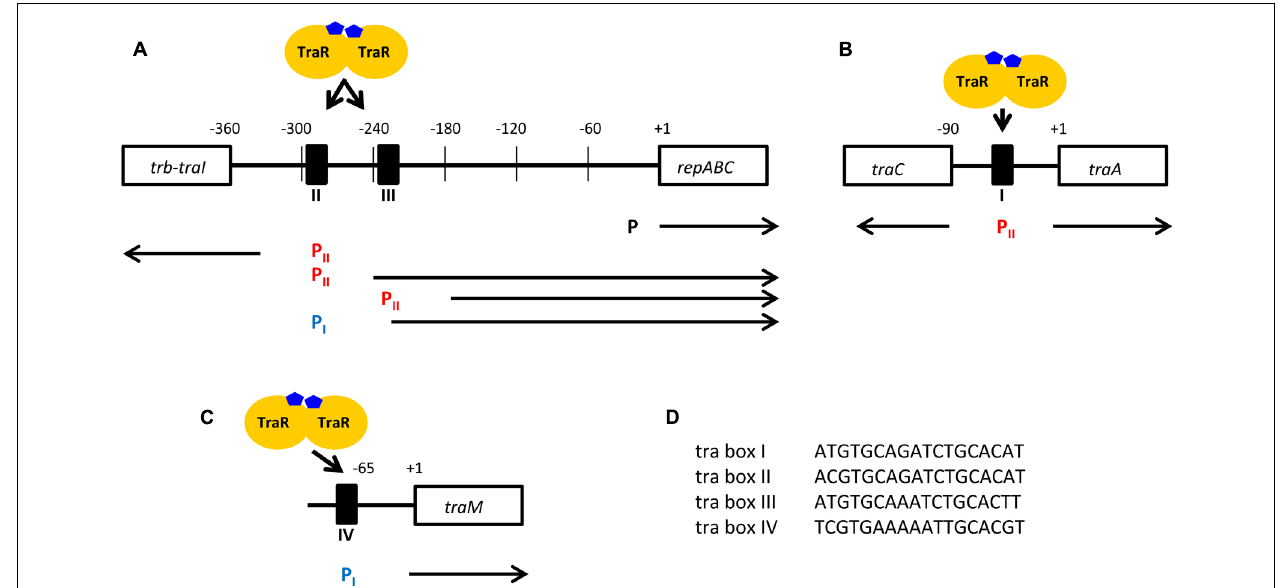
class I-type are in blue while those of class II-type are in red.The fourth identified promoter controlling the expression of repABC in a TraR-independent way is also displayed (P).The arrows indicate the direction of transcription. (D) The nucleotide sequences of the four tra boxes. (Adapted from Fuqua andWinans, 1996a; Pappas andWinans, 2003a,b;White and Winans, 2005).